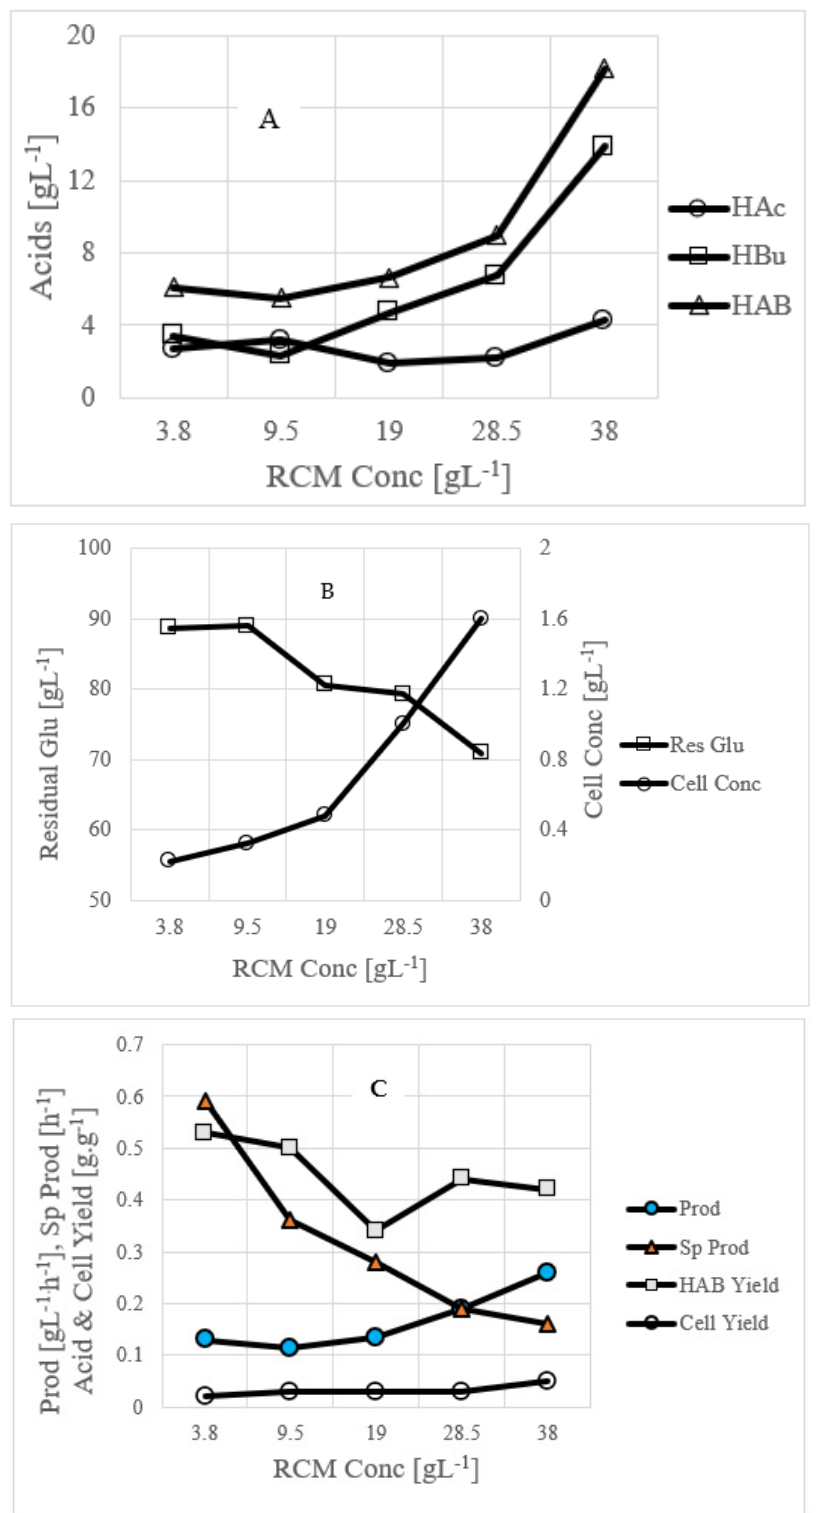
Figure 3. Effect of RCM on butyric acid production by C. tyrobutyricum . ( A ) Production of acids at various RCM concentrations; ( B ) residual glucose and cell concentration; ( C ) productivities, specific productivities, acid yield and cell yield. RCM—reinforced clostridial medium.